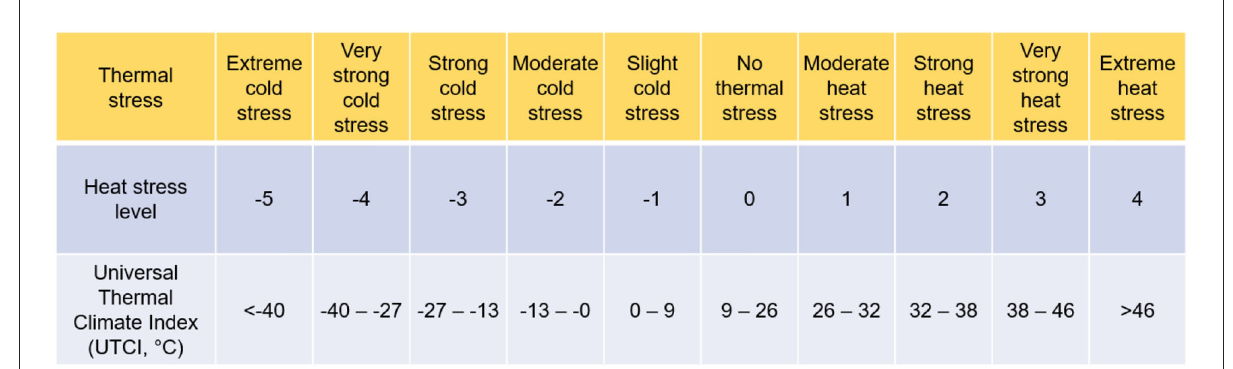
FIGURE5 Association between heat stress levels and